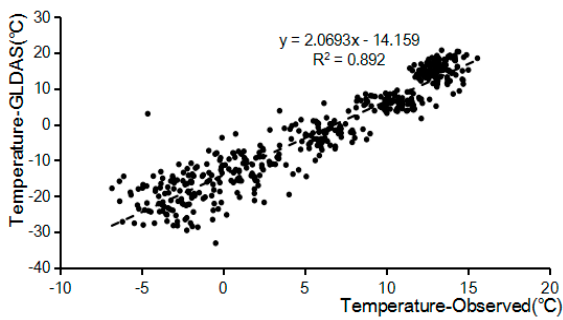
Figure 8. GLDAS and observed temperature changes from 1979 to 2016.